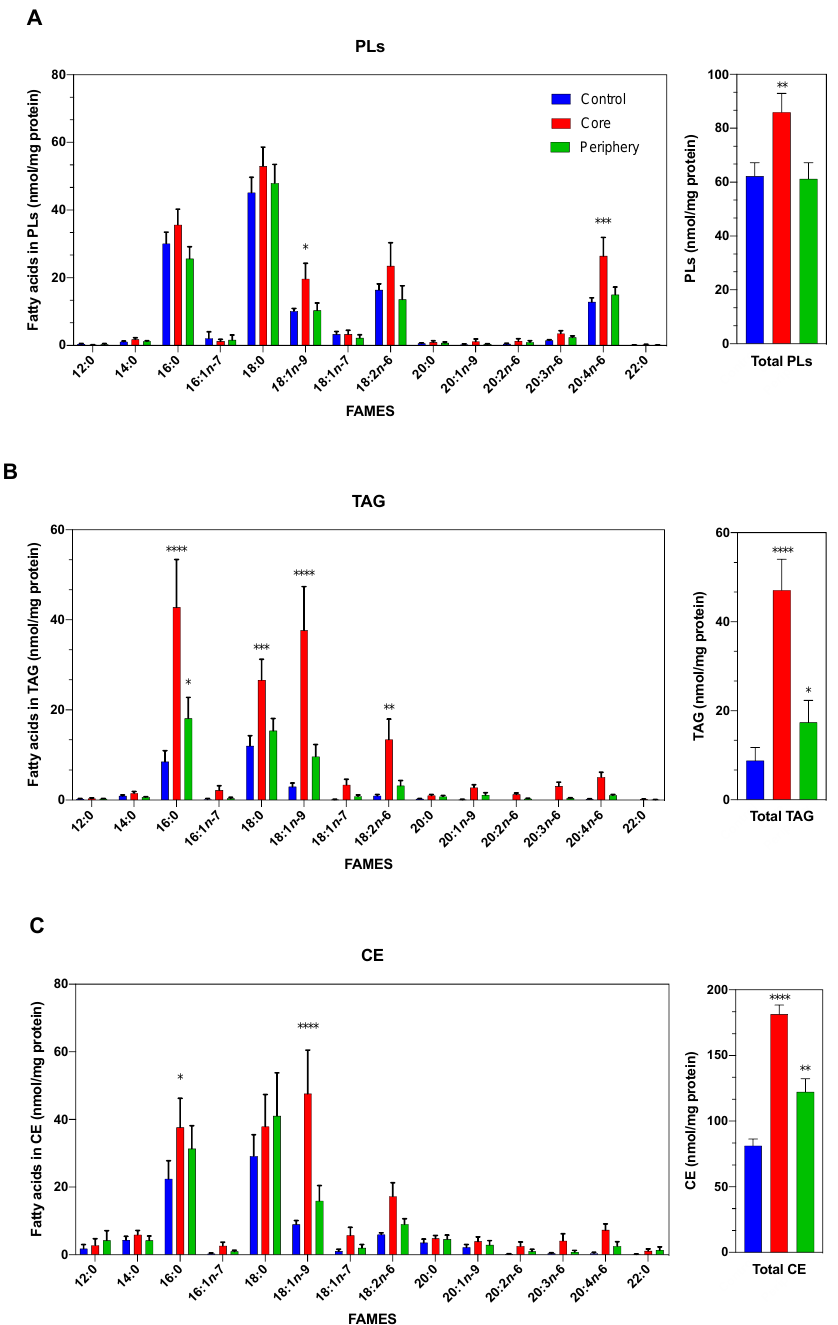
Figure 1. Lipidomic profile of ccRCC. ( A ) The profile of major phospholipid fatty acids in healthy distal normal tissue (blue bars) or tumors (core and periphery: red and green, respectively) were determined by GC/MS after converting the fatty acid glyceryl esters into fatty acid methyl esters. ( B , C ) Profile of fatty acids present in neutral lipids (TAG and CE). Data are expressed as the means ± SEM ( n = 12). * p < 0.05, ** p < 0.01, *** p < 0.001 and **** p < 0.0001, significantly different from the control.